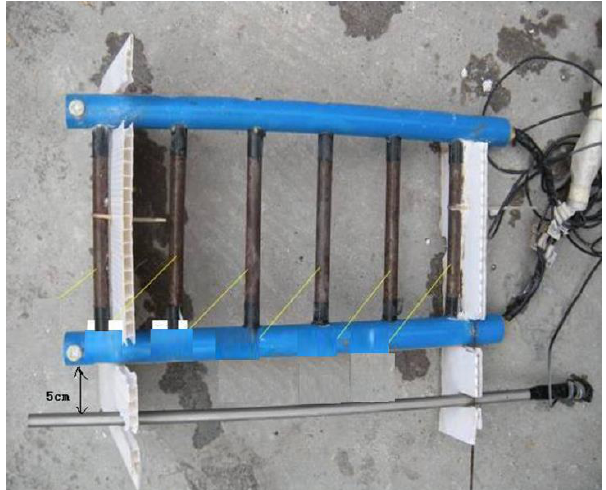
Figure 2. Examples of sensors based on macrocells in the “ladder” type: the inner electrodes are made of reinforcing steel, the outer one is made of stainless steel [52].